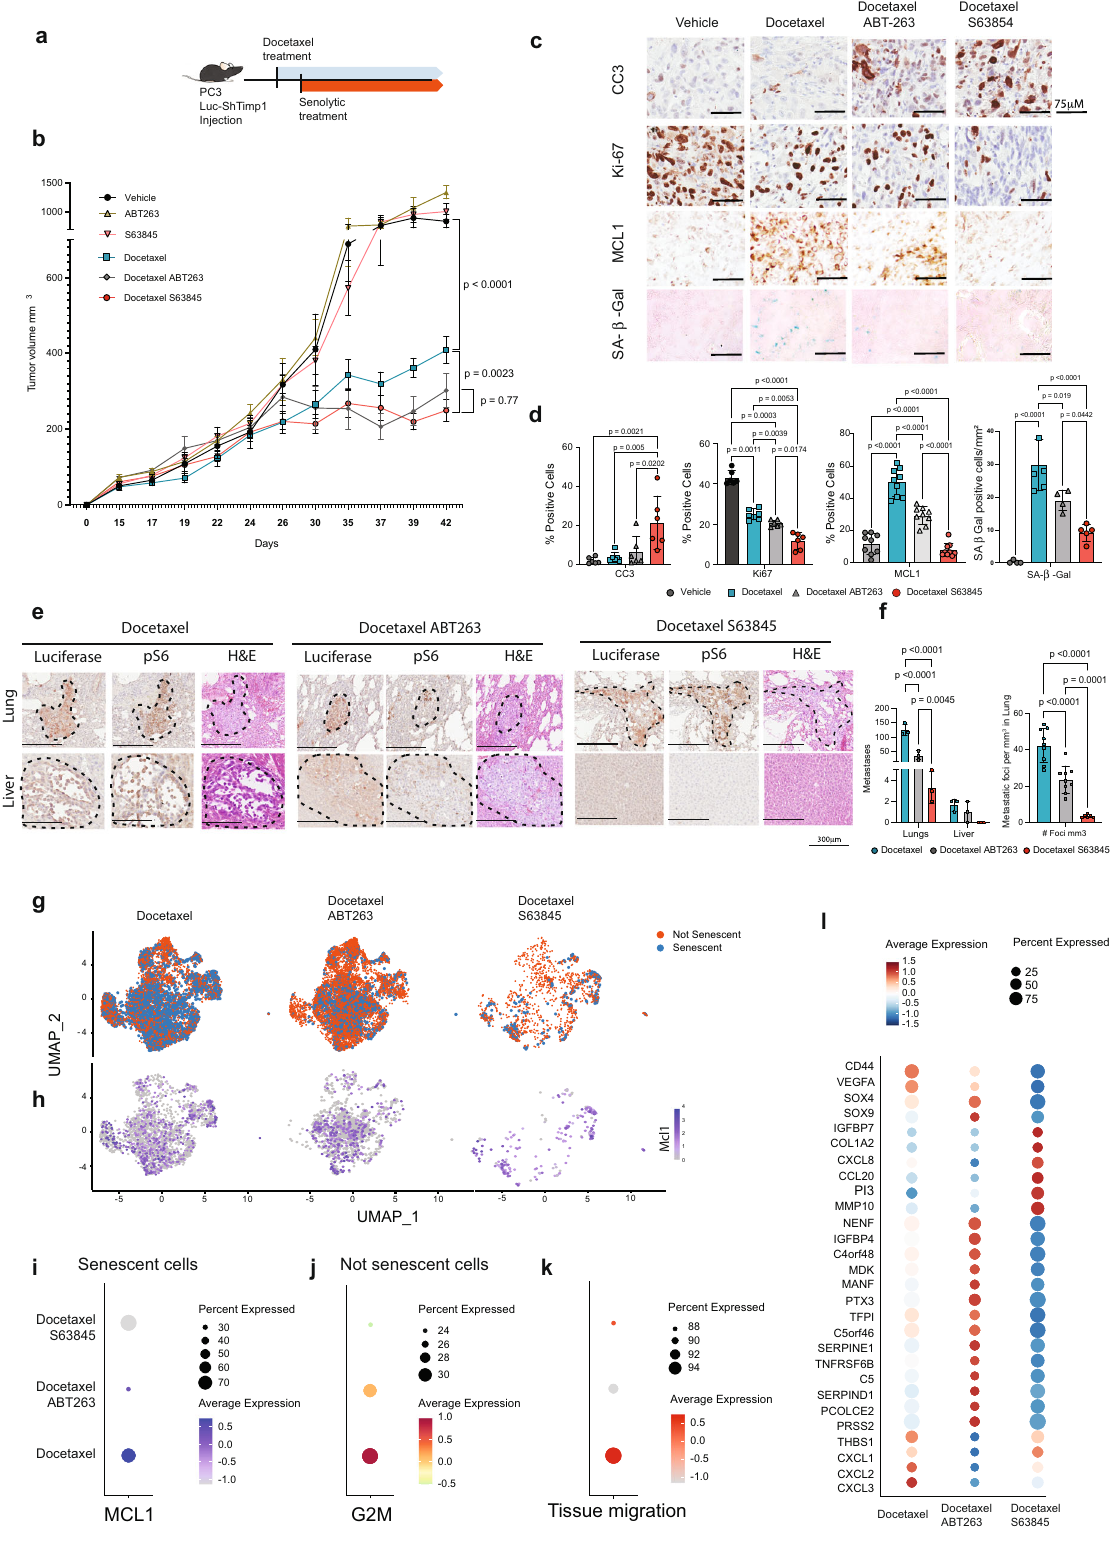
Single-cell sequencing data preprocessing and quality control . Sequencing data were processed by CellRanger 65 (version 3.1.0 for murine alignment and version 6.0.0 for xenograft derived-samples) and reads were aligned to mouse genome (mm10 v3.0.0) or human genome (GRCh38) with STAR 66 (v.2.5.1b). To reduce the ‘ dropout ’ phenomenon, RMagic package was used on gene-counts 67 . Single cell sequencing NATURE COMMUNICATIONS| (2022) 13:2177